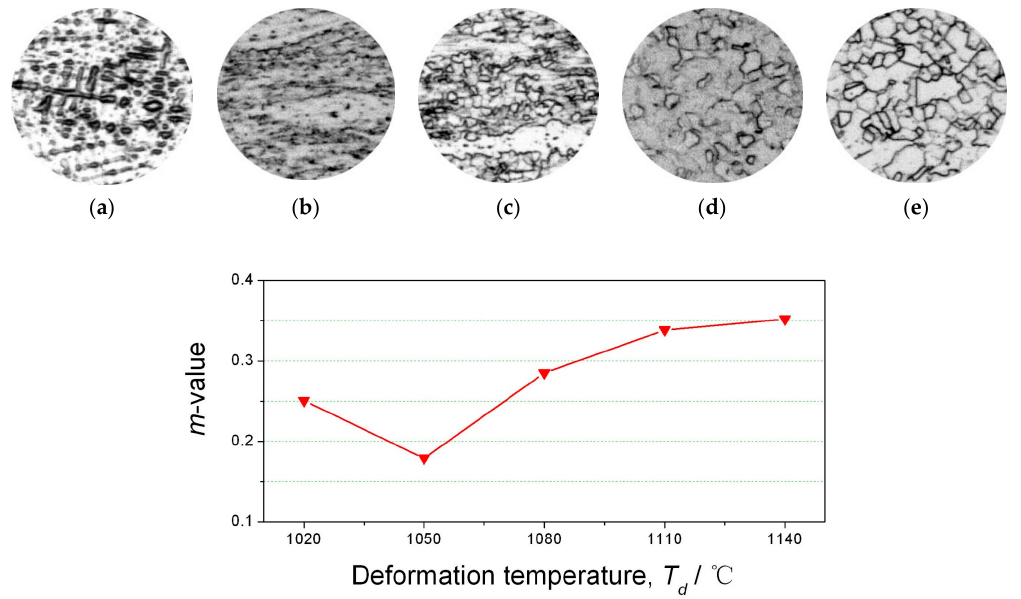
Figure 11. The microstructures and m -values of the PM/Wrought dual superalloy processed with the strain rate of 1.0 s − 1 at di ff erent deformation temperatures of ( a ) 1020 ◦ C; ( b ) 1050 ◦ C; ( c ) 1080 ◦ C; strain rate of 1.0 s − 1 at different deformation temperatures of ( a ) 1020 °C; ( b ) 1050 °C; ( c ) 1080 °C; ( d ) ( d ) 1110 ◦ C; ( e ) 1140 ◦ 1110 °C; ( e ) 1140 °C.